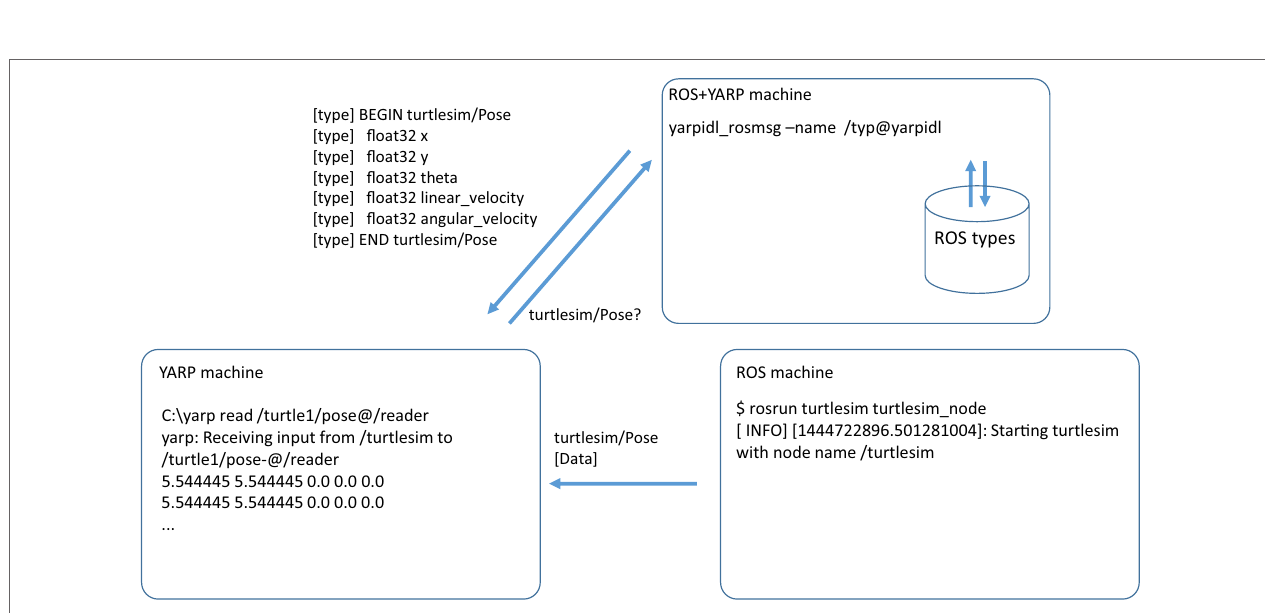
Figure 9 (left) represents represents the situation in which the Port Monitor (shown as a box with M) is attached to the